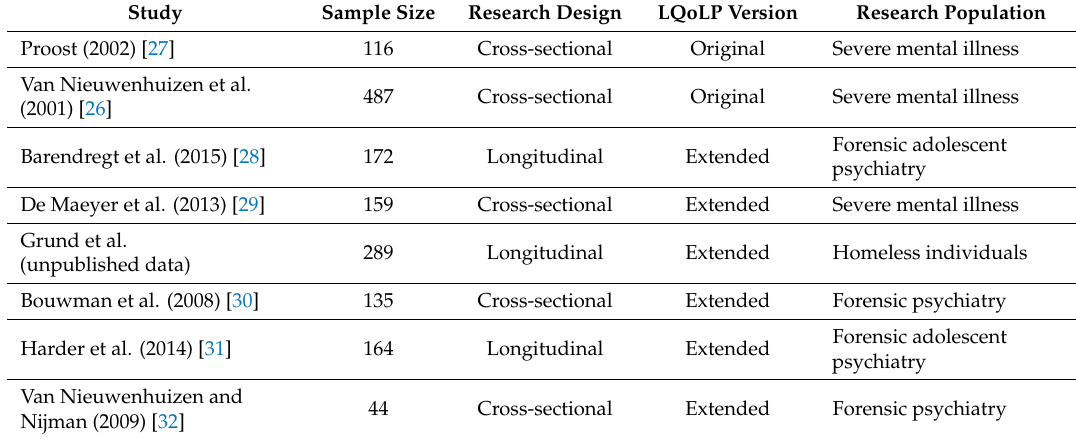
Table 1. Study characteristics of eight included